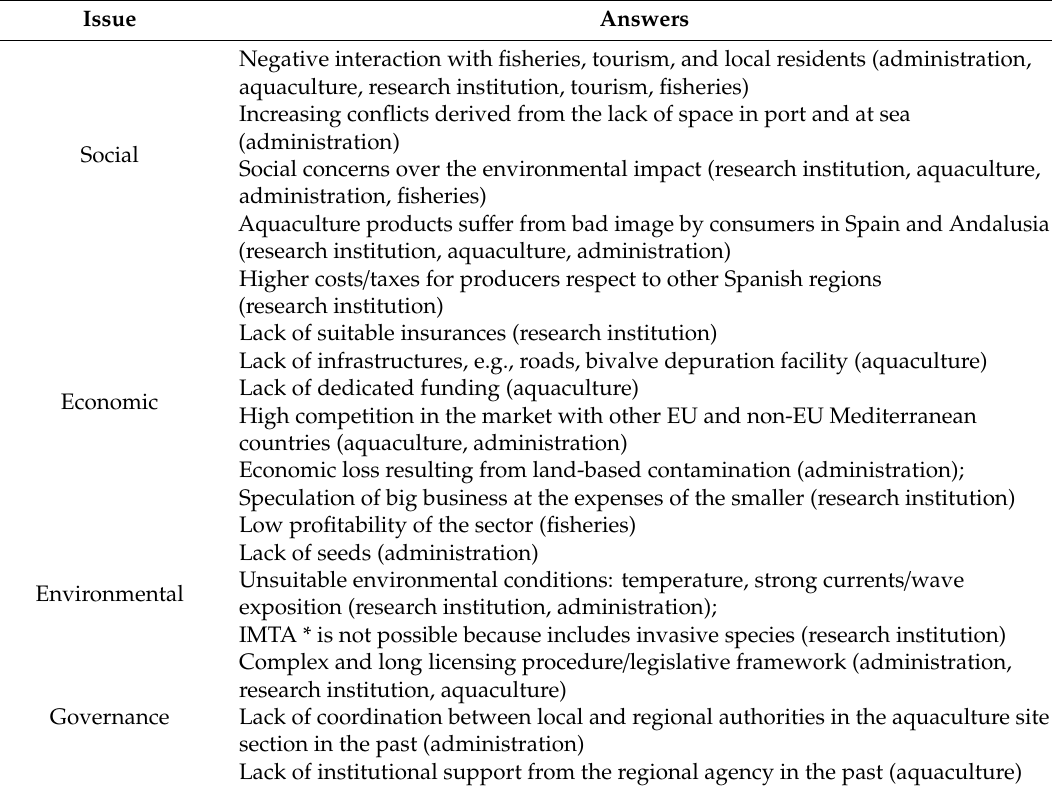
Table 3. Elements hampering aquaculture development of Andalusia according to the interviews (in brackets the category of